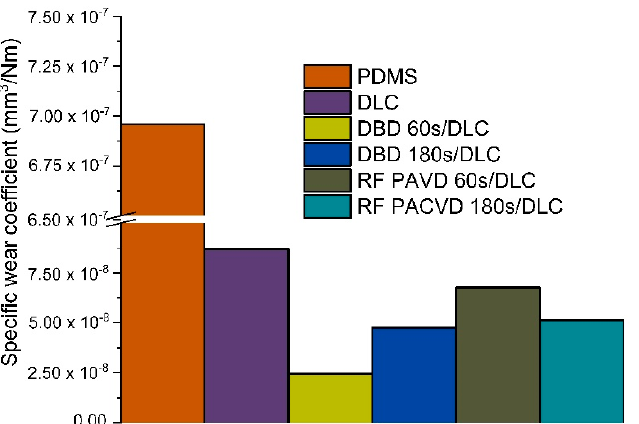
Figure 7. Analysis of wear rates achieved for substrates used in the tribological tests.